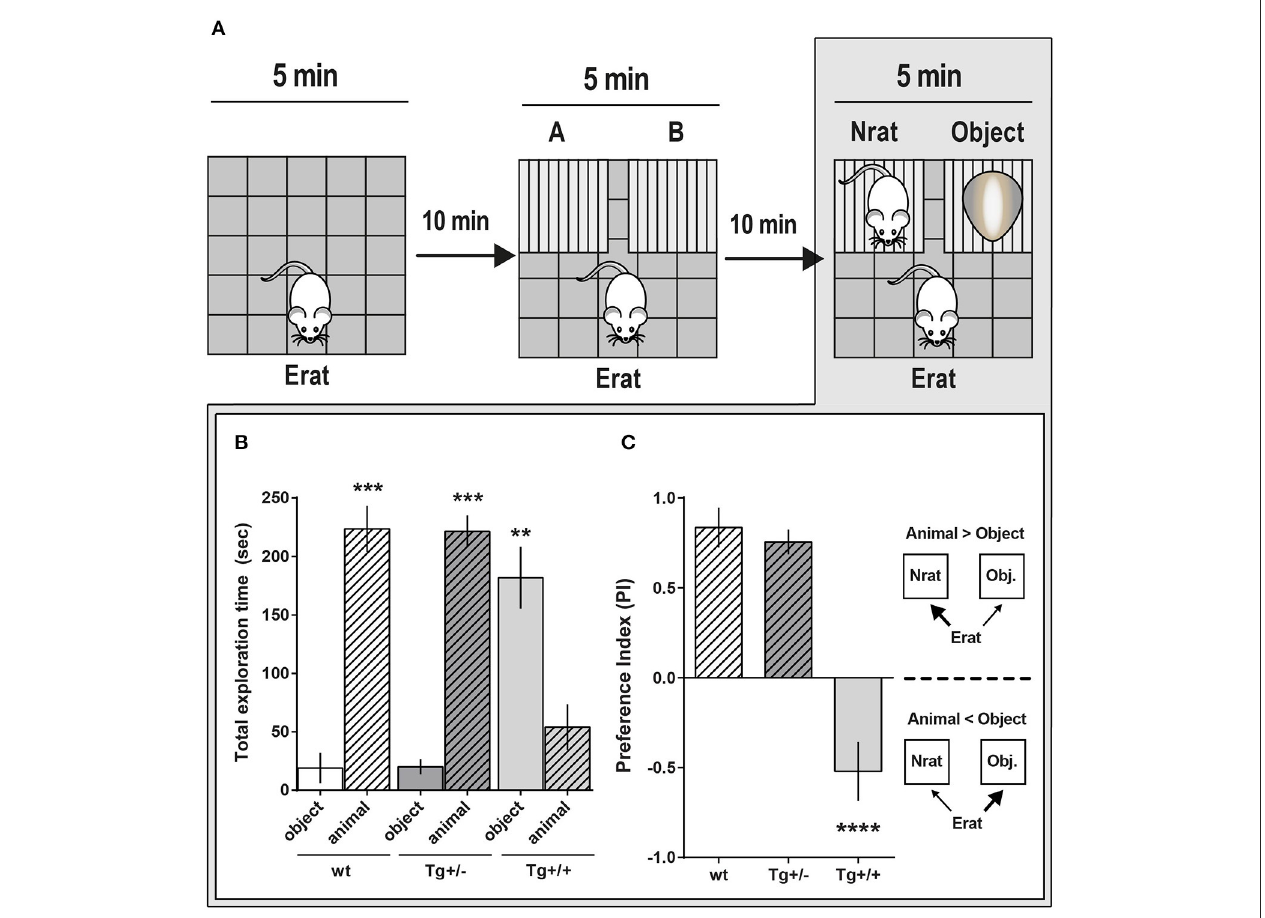
FIGURE 5 | Social approach comparative behavior of McGill-R-Thy1-APP Homozygous Tg + / + and Heterozygous Tg + /– rats. (A) Schematic representation of the task steps. 4-month-old Tg + / + , Tg + /– rats and their wt littermates were tested in an adapted version of the three-chambered task. Step 1: OF habituation. Step 2: Control for location/cages (lack of) preference. Erat explores the OF with A and B empty cages. Step 3: “Sociability” assessment. Erat explores the OF with a Nrat (novel rat, same sex, and age) in one cage, and an object (similar size and color than Nrat) in the other cage. (B) “Sociability”: Total exploration time of targets (Nrat or Object) during the 5min session (Step 3 in A). Bar diagram represents the time (mean ± SEM) an Erat spent exploring an unknown Nrat, or an unknown object (O). Tg + /– animals (dark gray bars, N Tg + / − = 13), Tg + / + animals (light gray bars, N Tg + / + = 6), wt littermates (white bars, N wt = 6). Object (O): stripped bars; Novel animal (Nrat): plain bars. Tg + /– and wt rats spent more time exploring a Nrat than the object; while Tg + / + rats spent significantly more time exploring the object (*** P < 0.001, ** P < 0.01, Paired t -test). (C) Sociability Preference Index (PI = Nrat–O/Nrat + O) was calculated using the data shown in B . During the social task, wt (white bars) and Tg + /– (dark gray bars) Erats spent more time exploring the Nrat than the object (PI N − 0 > 0; plain bars), while Tg + / + Erats spent more time exploring the object than the Nrat (PI N − 0 < 0; stripped bars). **** P < 0.0001, One-way ANOVA, Dunnett post- hoc